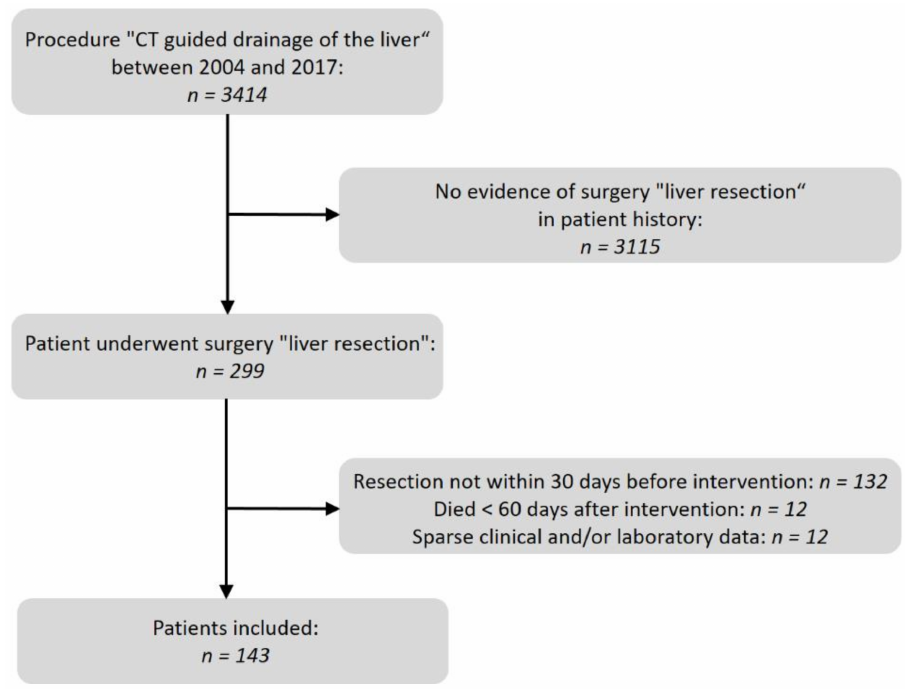
Figure 1. Flow chart of the patient selection process. n: number of